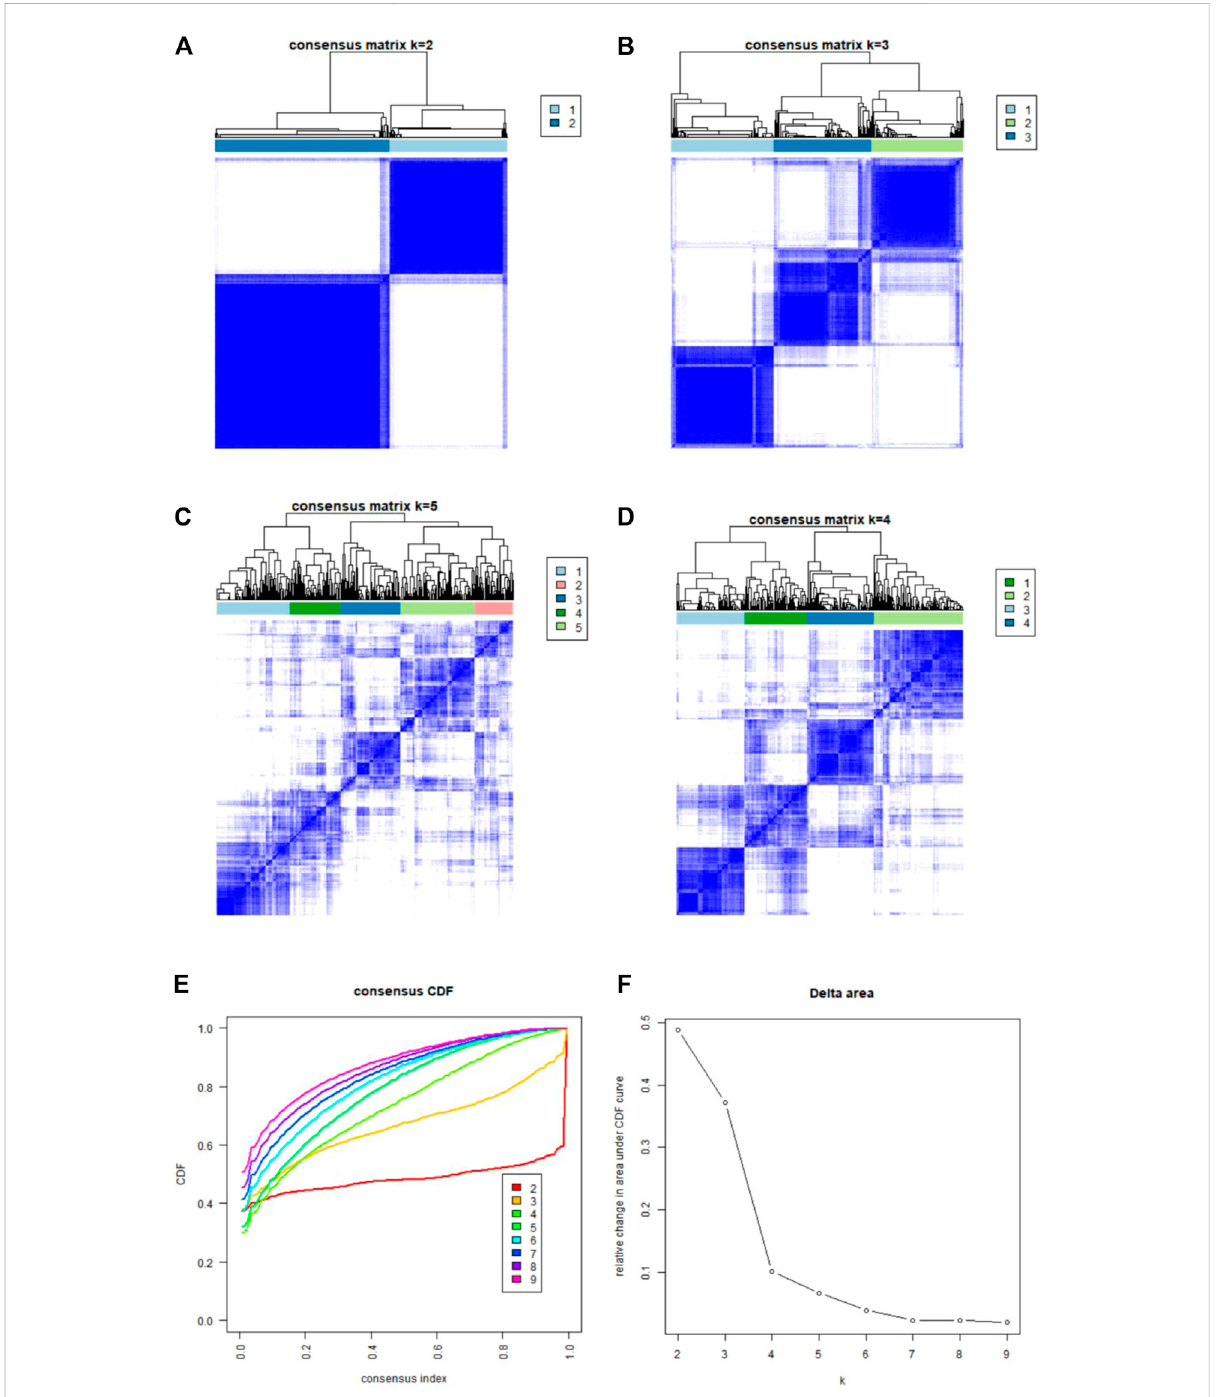
FIGURE 4 Consensus clustering of the 25 ferroptosis- and necroptosis-related genes in patients with CAD. (A – D) Consensus matrices of the 25 ferroptosis- and necroptosis-related genes for k = 2 – 5. (E) CDF curve for k = 2 – 9. (F) Delta area scores of the CDF curve for k = 2 –